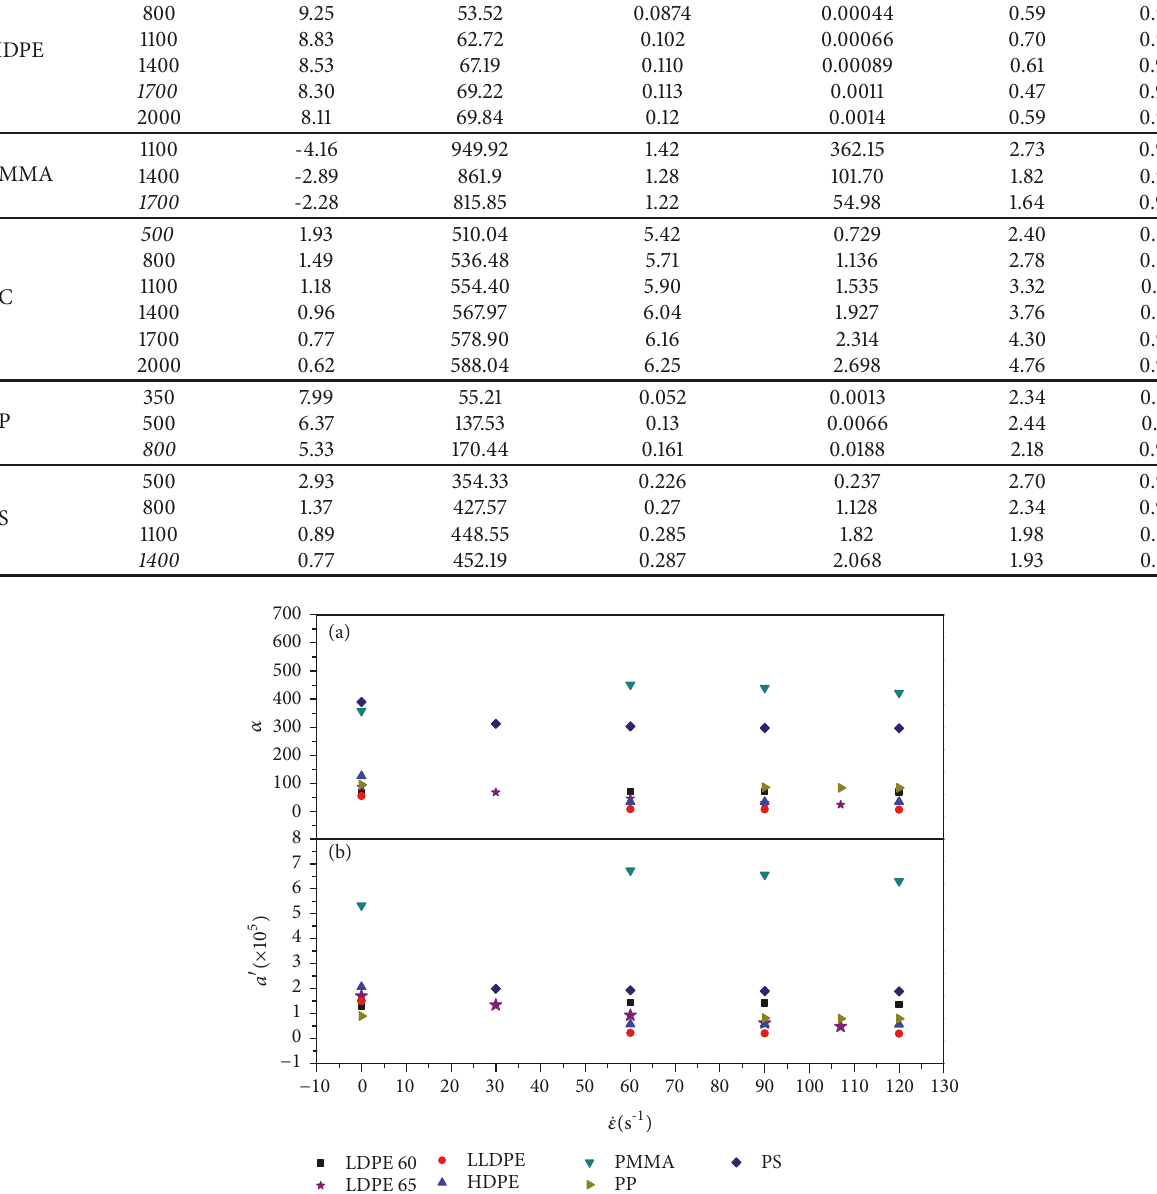
Figure 7: The elongational rate dependency of computed parameters 𝛼 and 𝑎 󸀠 calculated by (7) and